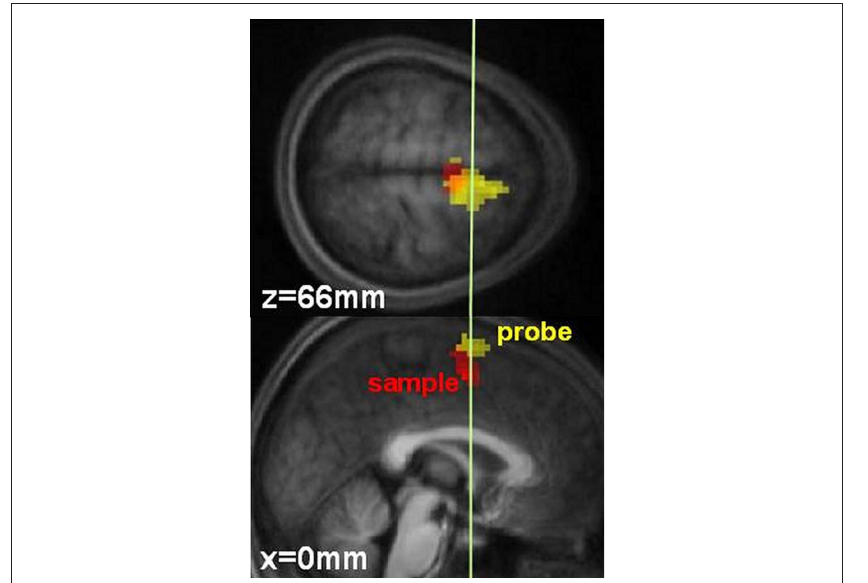
Figure 2 | Temporal processing by the SMAs in 14 subjects. Red represents activation obtained during sample stimuli presentation. Yellow represents activation obtained during probe stimuli presentation. The white line ( y = 0 mm) denotes the border between the SMA proper and the pre-SMA. X and Z correspond to the coordinates of each slice. Adapted from Coull et al. (2008).